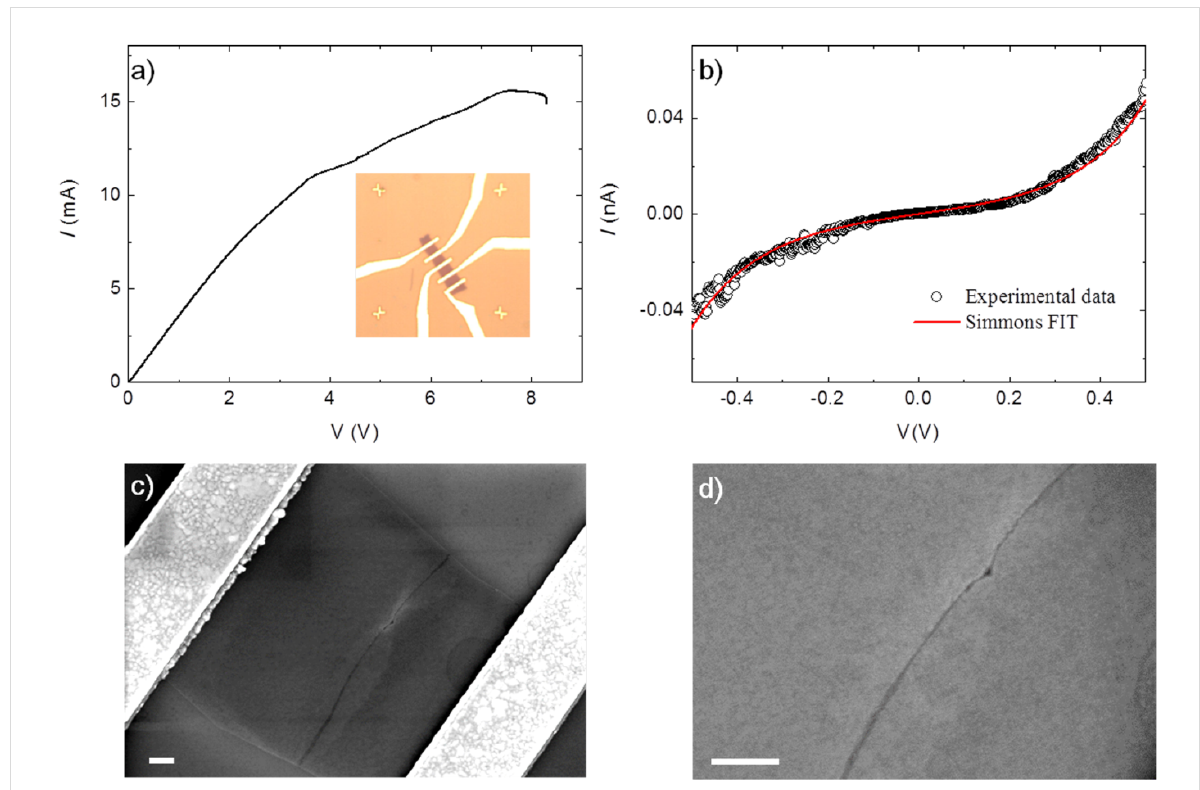
Figure 1: a) I – V curve recorded for a typical electroburning (EB) process. Inset: optical image of one of the few-layer graphene flakes used (the dis- tance between the crosses at the corners is 45 µm); b) example of an I – V measurement for a device showing a sizeable tunneling current after the EB process. The black circle are the experimental data and the red line is the fitting according to the Simmons model by using the following parameters: gap size d = 1.83 nm; junction area A = 5 nm 2 ; barrier height Φ = 0.6 eV; c) and d) corresponding SEM images showing the opening of a gap that is a few nanometers wide (scale bars: 300